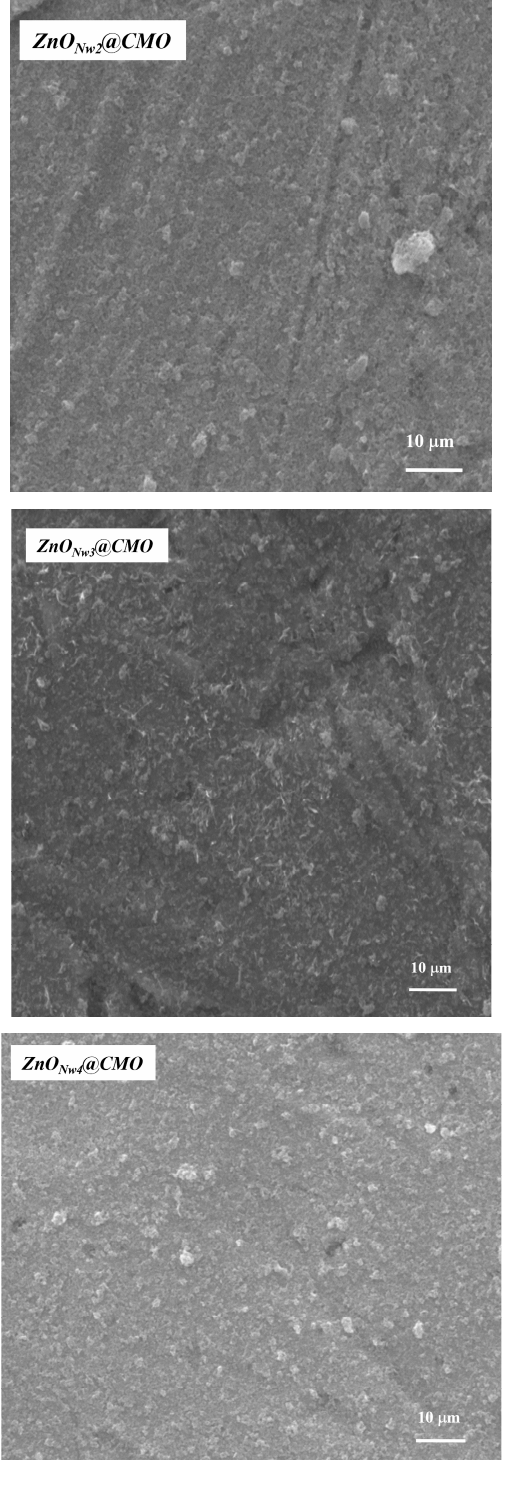
Figure 5. SEM morphology of the as-obtained ZnO Nw @CMO sensors.